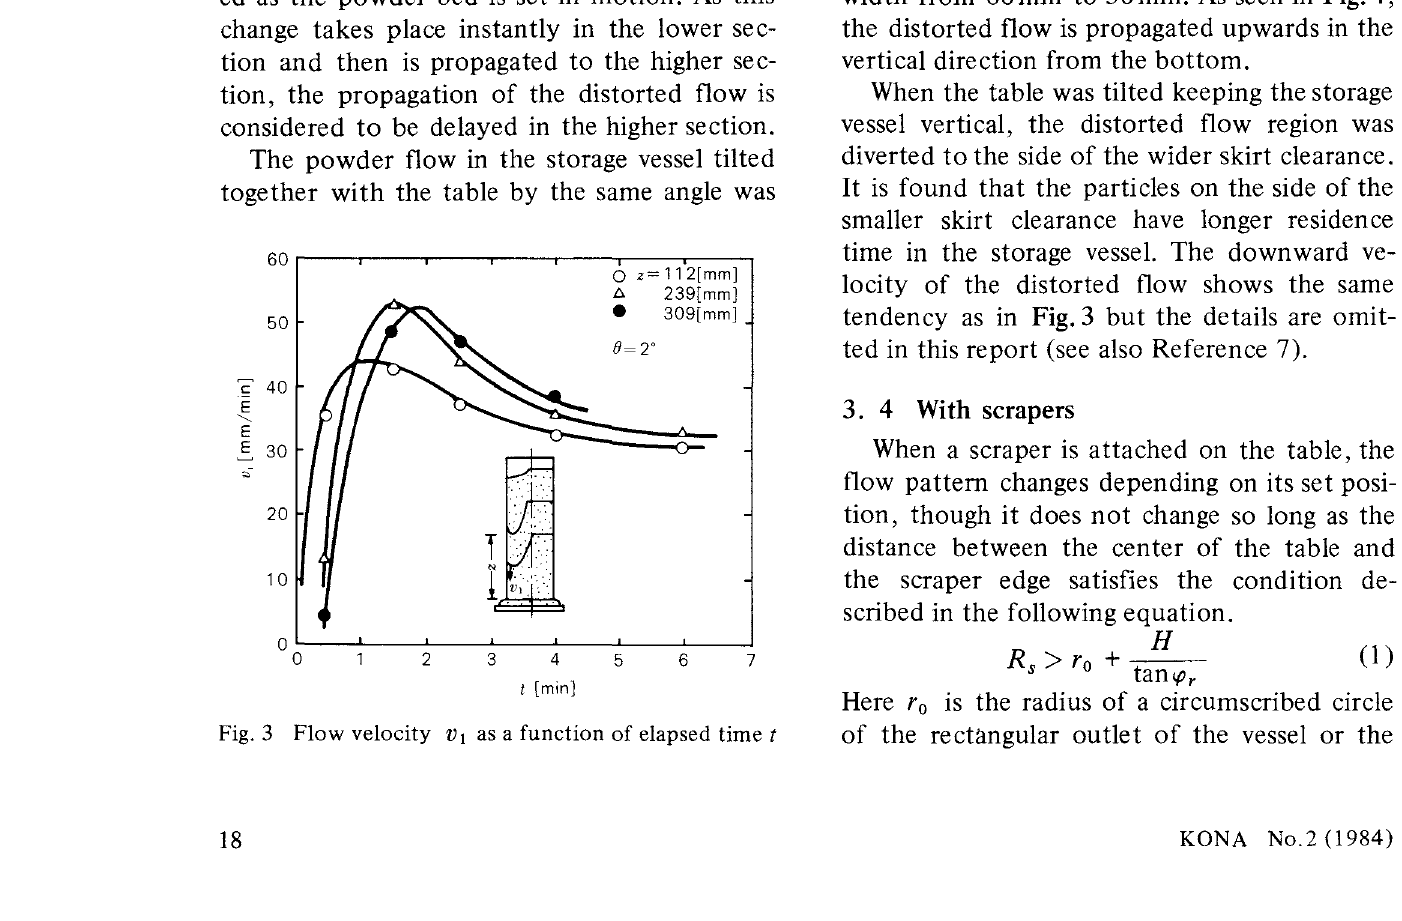
Fig. 3 Flow velocity v 1 as a function of elapsed timet